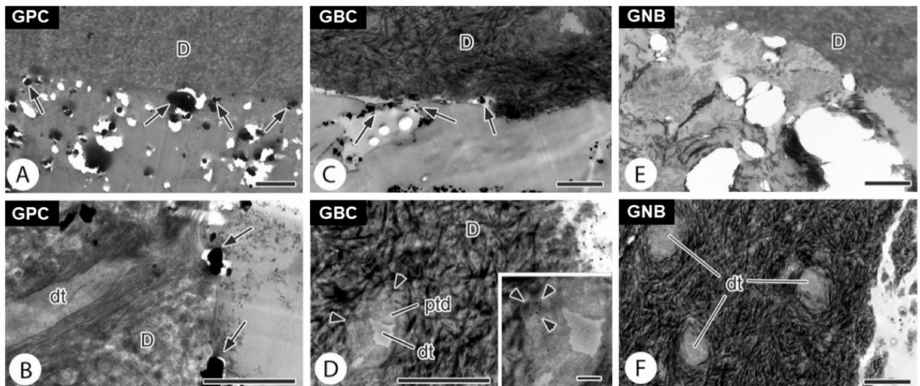
Figure 3. Representative transmission electron microscopy (TEM) images of the GPC ( A , B ), GBC ( C , D ), and GNB ( E , F ) groups. Presence of lanthanum at the interface (black arrows) in the GPC and GBC groups. DT: tubular dentin, D: dentin, PTD: peritubular dentin. (Scale bar: 800 nm; figure D zoom—200